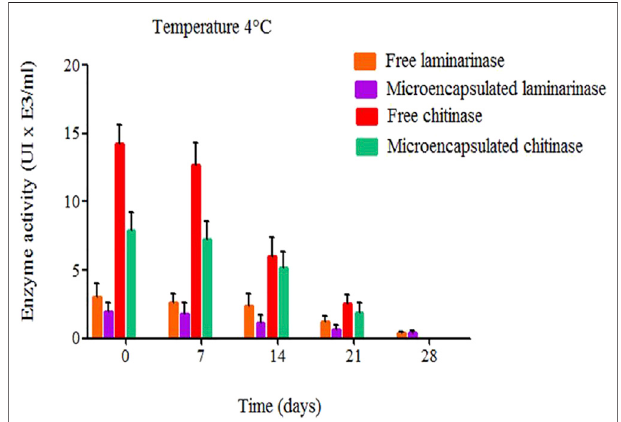
FIGURE 6 | Microencapsulated and free chitinase and laminarinase activity (both at 0.01 mg/ml) during storage at 4 ° C (Cano-Salazar et al., 2011; Pérez-Molina et al.,